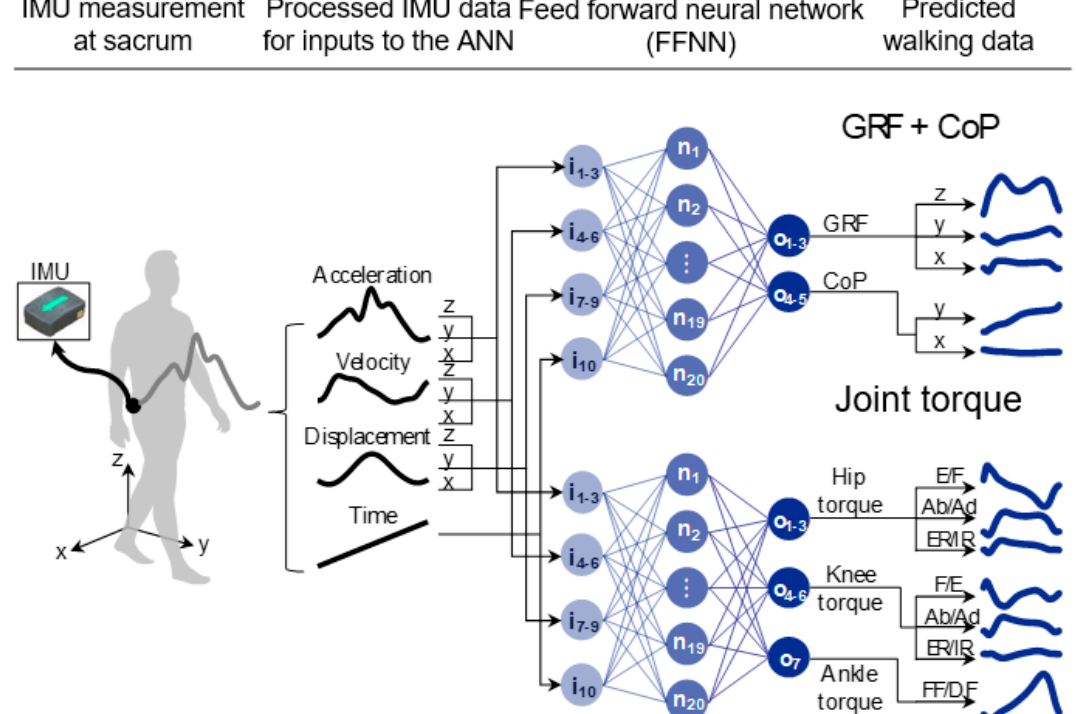
Figure 1. Schematics of the estimation procedures of lower limb kinetics data with a single inertial measurement unit (IMU) using an artificial neural network (ANN). One network predicted the ground reaction forces (GRFs) and center of pressure (CoP), and the other network predicted the joint torques. Measured and processed IMU data such as the acceleration, velocity, position, and time were fed into input nodes of the ANNs. Each ANN has 10 input nodes followed by one hidden layer of 20 nodes, and 5 or 7 output nodes, respectively. The output predictions are the vertical, anteroposterior (AP), and mediolateral (ML) GRFs, the AP and ML CoP, and the three-dimensional joint torques of hip, knee, and